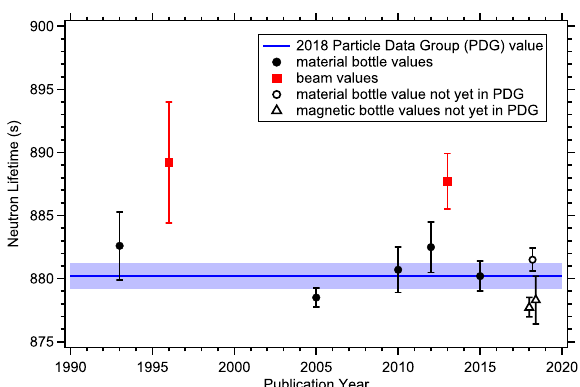
Figure 1. Plot of recent lifetime measurements; all uncertainties are one standard errors. Beam values are shown in solid red squares [11,15] while UCN material bottle values are shown in solid black circles [16–20]. The 2018 Particle Data Group (PDG) evaluation is shown by the blue line and shaded band. The open circles (material confinement) [21] and open triangles (magnetic confinement) [22,23] are bottle values not yet included in the PDG